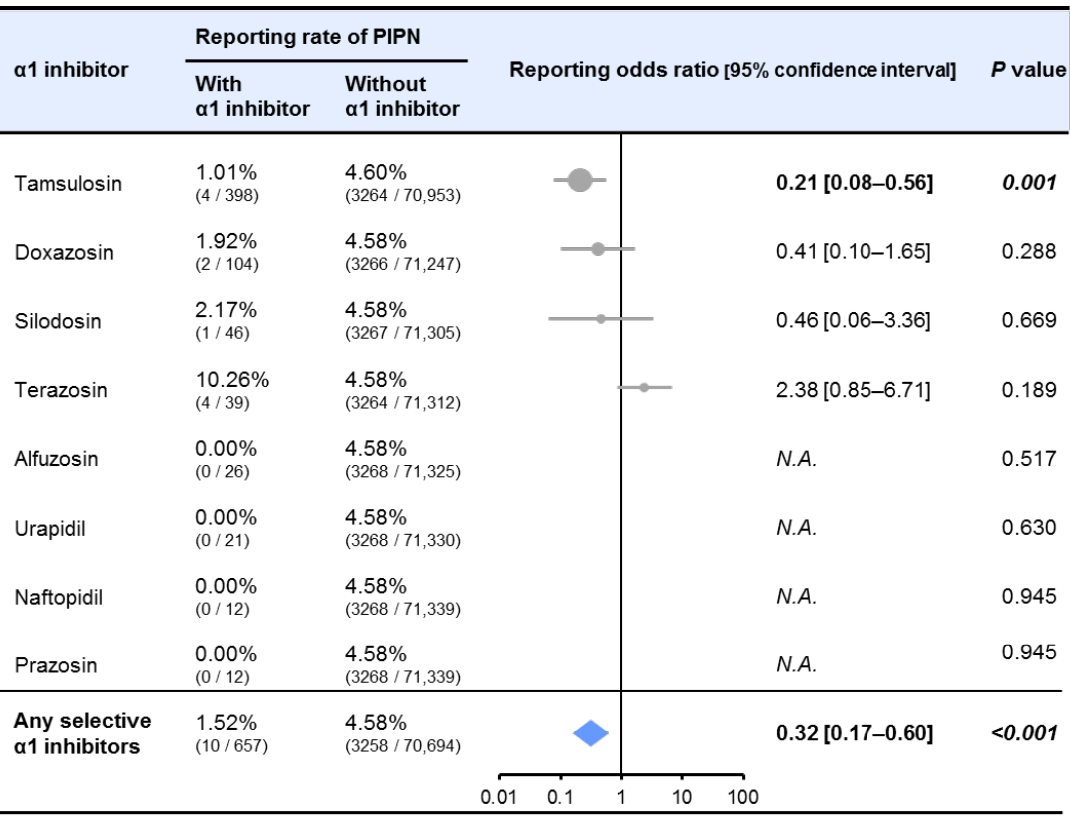
Figure 4. Effects of α 1 receptor antagonists on reporting ratio of paclitaxel-induced peripheral neuropathy (PIPN) in Food and Drug Administration Adverse Event Reporting System (FAERS). The reported data were extracted using CzeekV Pro (version 5.0.23, INTAGE Healthcare Inc., Tokyo, Japan, accessed April 2021). A total of 71,351 adverse event reports from patients using paclitaxel were included in this study. PIPN was defined as reports pertaining to peripheral neuropathy, peripheral sensory neuropathy, or peripheral sensorimotor neuropathy in patients using